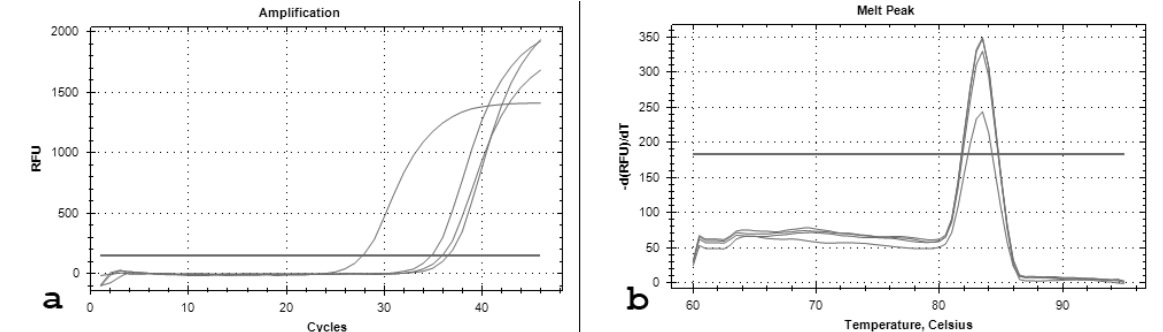
Figure 3. Amplification (Figure 3a) and Dissociation (Figure 3b) curves obtained with one of the described pairs of primers and DNA of wheat grain infected with